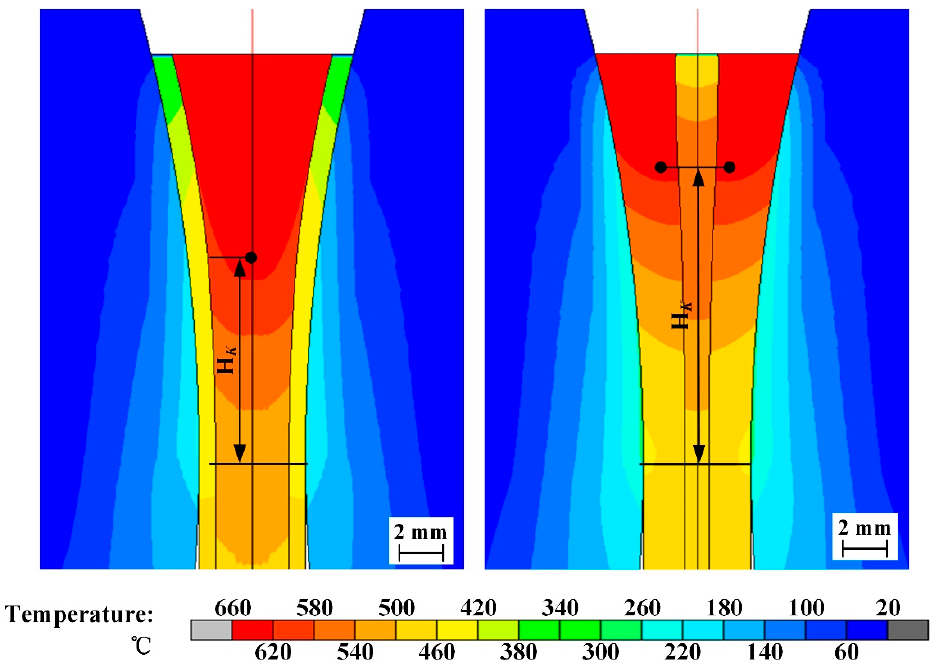
Figure 16. Comparison of the temperature distribution of the two processes. ( left ) SLS-TRC; ( right ) LSL- TRC.